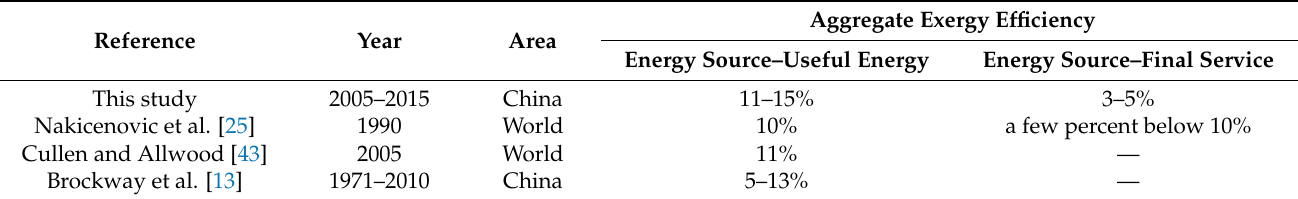
Table 4. Comparison of results with previous